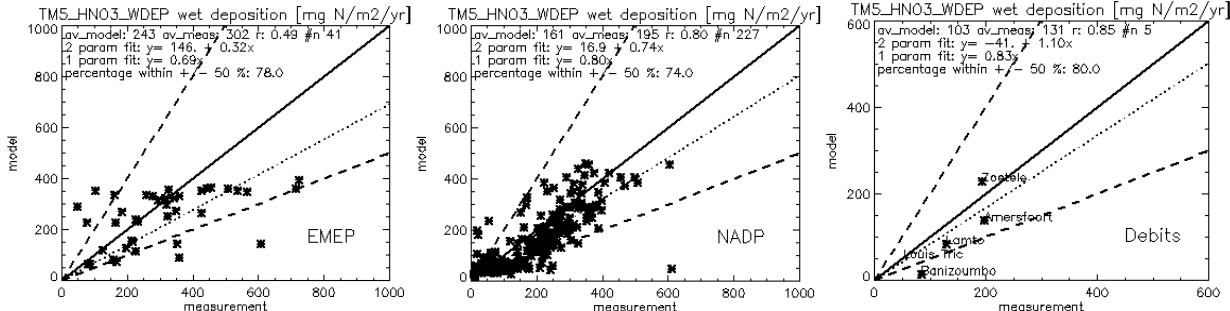
Fig. 13. Scatter plots of the simulated HNO 3 wet deposition versus measurements for three networks in Europe (left panel), North America (middle panel), and Africa (right panel). Dashed lines have slopes equal to 2 resp. 0.5. The dotted line is the result of linear regression fitting through the